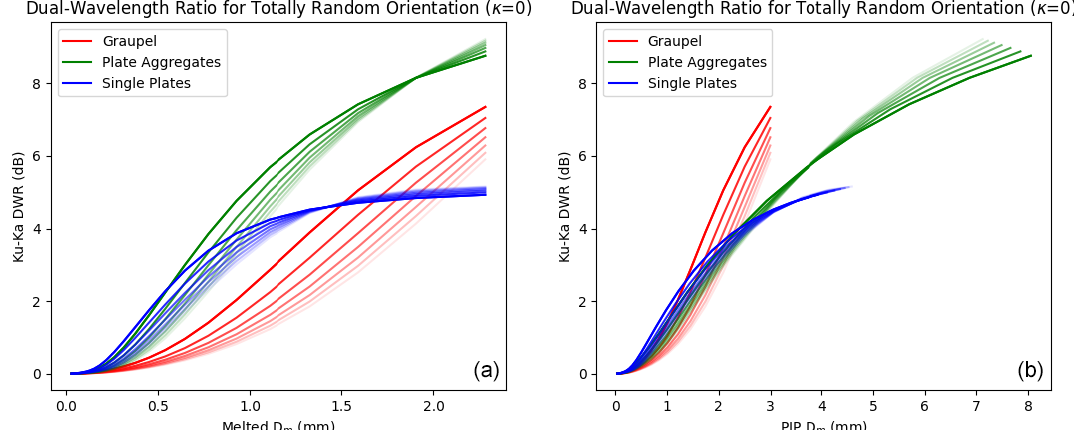
Figure 3. Ku–Ka dual-wavelength ratio for the three ice species listed in Table 2 as a function of the melted (volume equivalent) D m (a) and D P (b) . The families of curves represent different values for the shape parameter µ ranging from − 1 to 5, with lighter shades indicating higher values and less dispersion of the PSD. The different ranges of D P are a consequence of the different size–density relationships for each species.